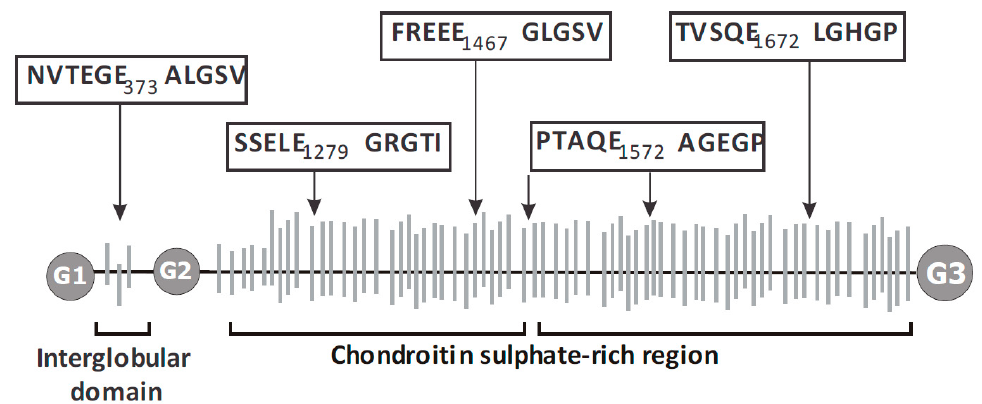
Figure 1. Aggrecanase cleavage sites and neoepitopes in the mouse aggrecan core protein. The domain structure of the mouse aggrecan core protein, with globular G1, G2 and G3 domains and intervening interglobular and chondroitin sulphate-rich regions are shown. The amino acid sequences flanking the conserved cleavage sites are shown in boxes with amino acid numbers at the P1 position. Modified from [12].